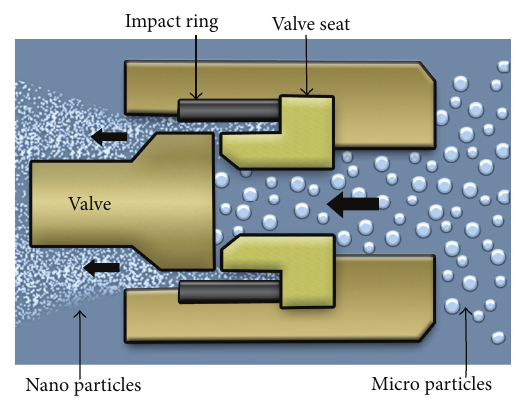
Figure 4: Schematic representation of the high-pressure homoge- nization process